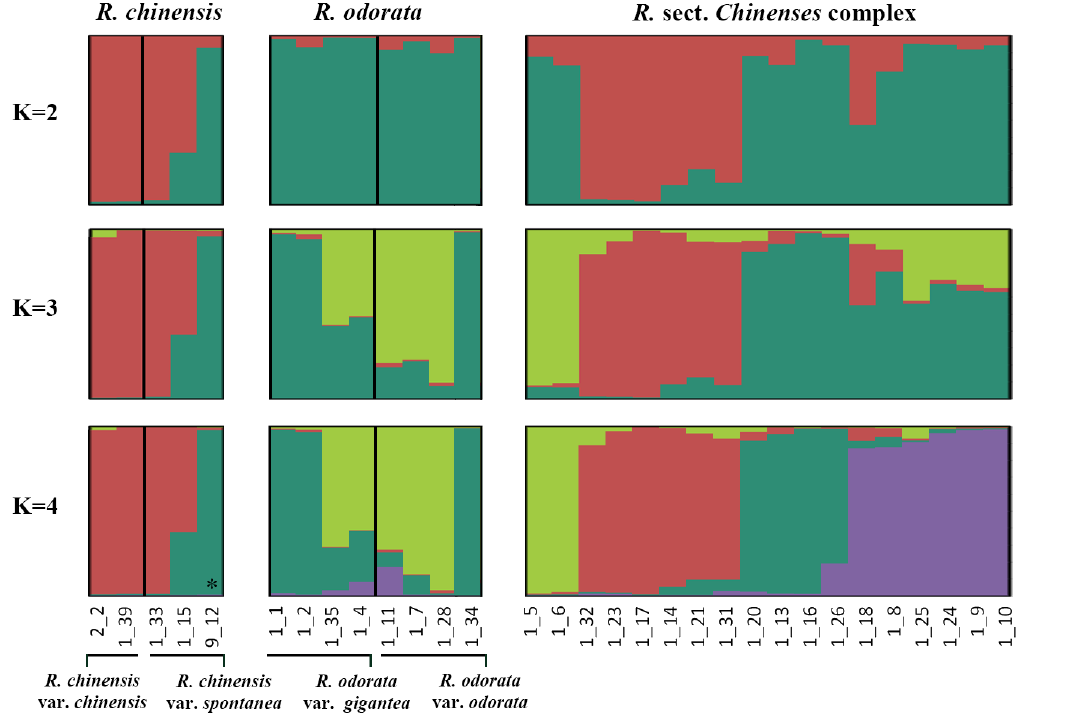
Figure 3. Genetic structure of R . sect. Chinenses .